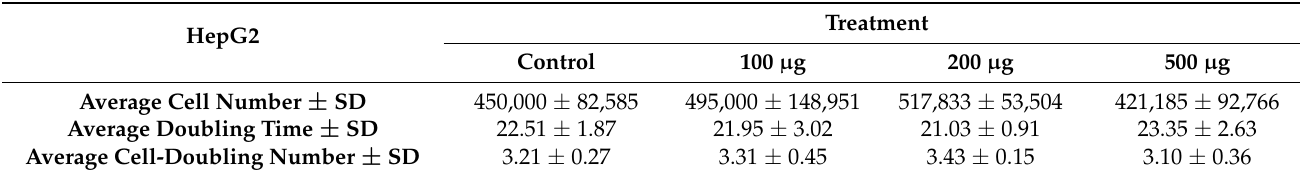
Figure 4. Direct cell count of HepG2 and At-MSCs after LLP treatment: ( A ) HepG2: no statistically significant difference was observed for average cell number following LLP treatment ranging from 100 µ g to 500 µ g; ( B ) At-MSCs: following treatment with 100, 200, and 500 µ g of LLP, a statistically significant increase in cell number was observed ( p < 0.001). Different letters indicate statistically significant differences. Table 1. Average cell number, cell-doubling time, and cell-doubling number of HepG2 cells treated with different LLP amounts (100 to 500 µ g). No statistically significant differences were observed for average cell number, cell-doubling time, and cell-doubling number for the different treatments compared to untreated control cultures.